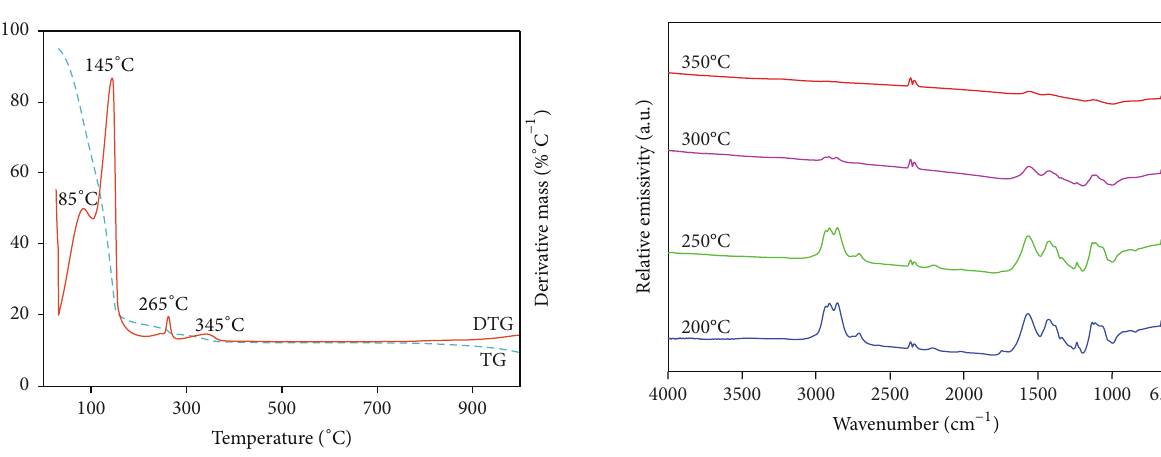
Figure 2: TG/DTG curves of the gel sample that heated from 25 to 1000 ∘ C.